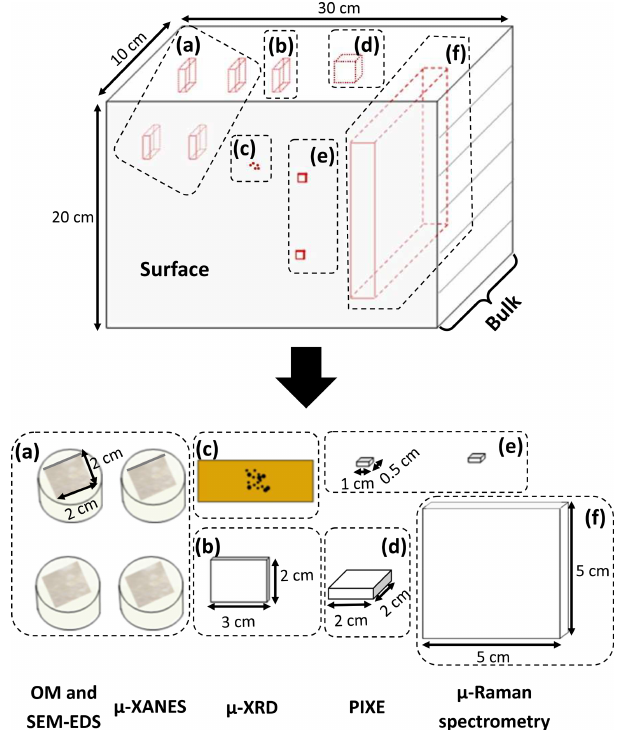
Figure 4. Schematic views of the different samples prepared from a given block for analyses. “Surface” stands for the interface be- tween the atmosphere and the building stone. “Bulk” refers to the inside of the sandstone block, patina excluded. (a) 2 × 2cm 2 sam- ples embedded in resin for optical microscopy, SEM-EDS, and µ- XANES; (b) 2 × 3cm 2 thin strip and (c) patina powder for XRD; (d) 2 × 2cm 2 sample for PIXE; (e) 1 × 0.5cm 2 surface samples for PIXE and µ-Raman spectroscopy; (f) 5 × 5cm 2 slice for µ-Raman